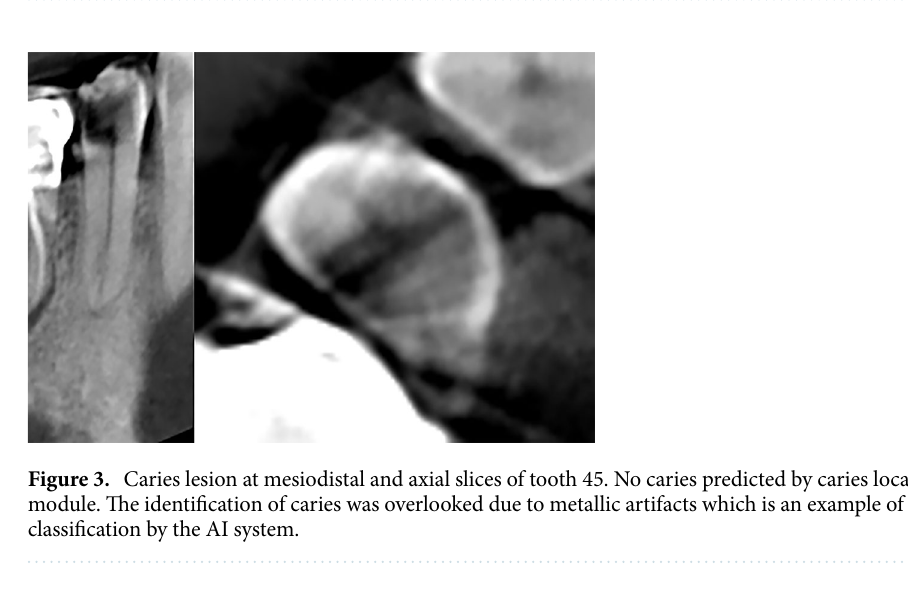
Figure 2. Caries lesion localization mask at the sagittal slice of tooth 17.